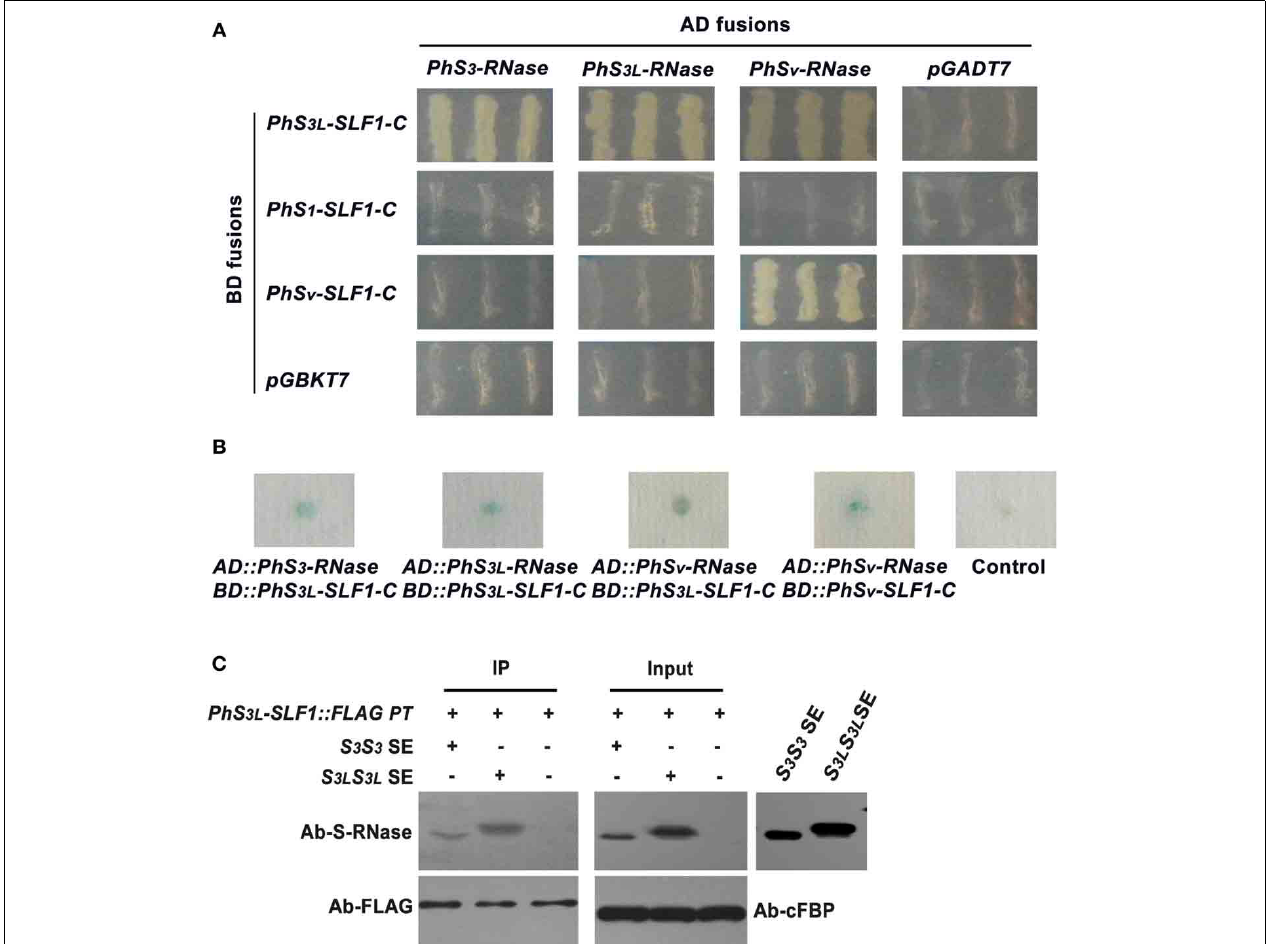
FIGURE 3 | PhSLFs selectively interact with PhS-RNases. (A) Yeast two-hybrid assays between PhSLFs and PhS-RNases. Cells of yeast strain AH109 containing various combinations of bait (BD fusions) and prey (AD fusions) were tested for their growth on selective medium SD/-Ade-His-Leu-Trp. The empty vectors pGBKT7 and pGADT7 were negative controls. (B) The β -galactosidase activity assay was used to further test the interaction of PhSLFs and PhS-RNases. The combination of empty pGBKT7 and pGADT7 was used as a negative control. (C) Co-immunoprecipitation